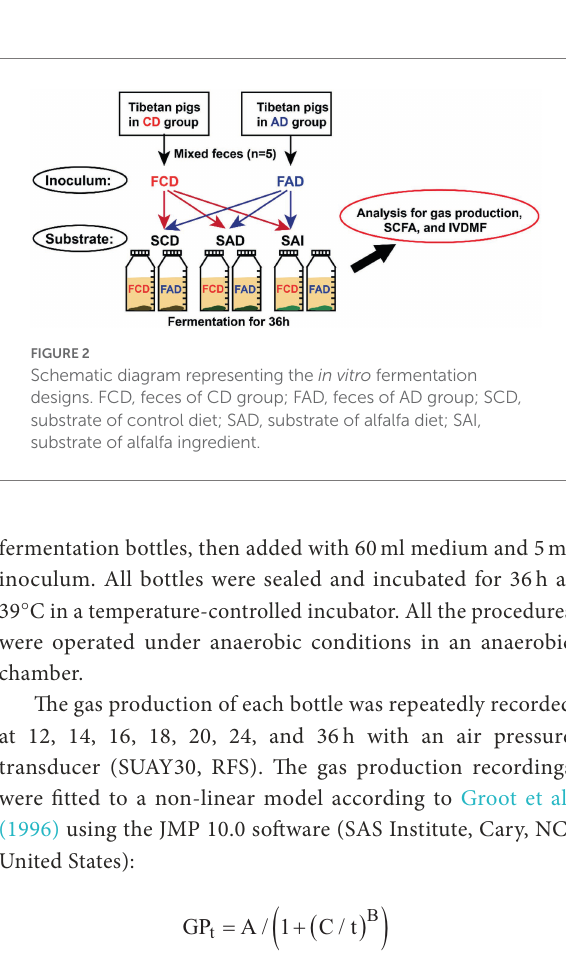
(Supplementary Figure S2A, S1B). Rank-Abundance curves